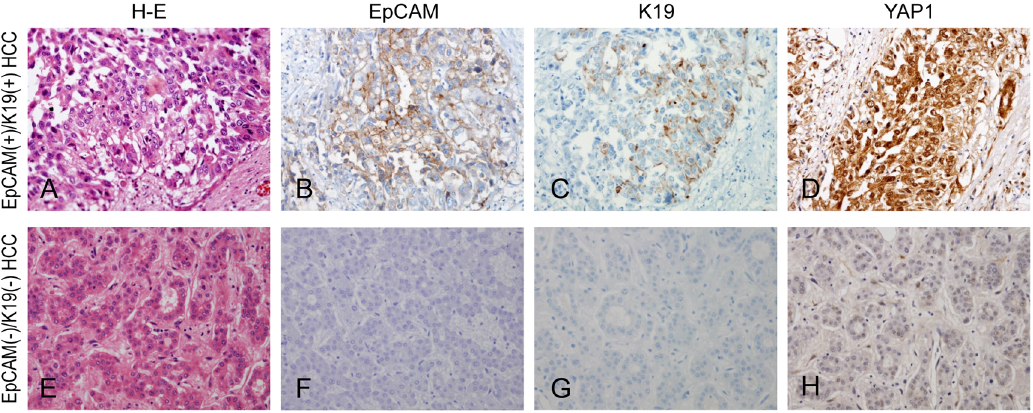
Figure 1. EpCAM and K19 expression in hepatocellular carcinoma (HCC). (A-D) HCC expressing both EpCAM and K19. The expression of EpCAM was mainly membranous, and K19 showed cytoplasmic expression in tumor cells. Nuclear expression of YAP1 was noted. (E-H) HCC without expression of both EpCAM and K19. There was no nuclear expression of YAP1. (Original magnification, 6 200). doi:10.1371/journal.pone.0075449.g001 PLOS ONE |